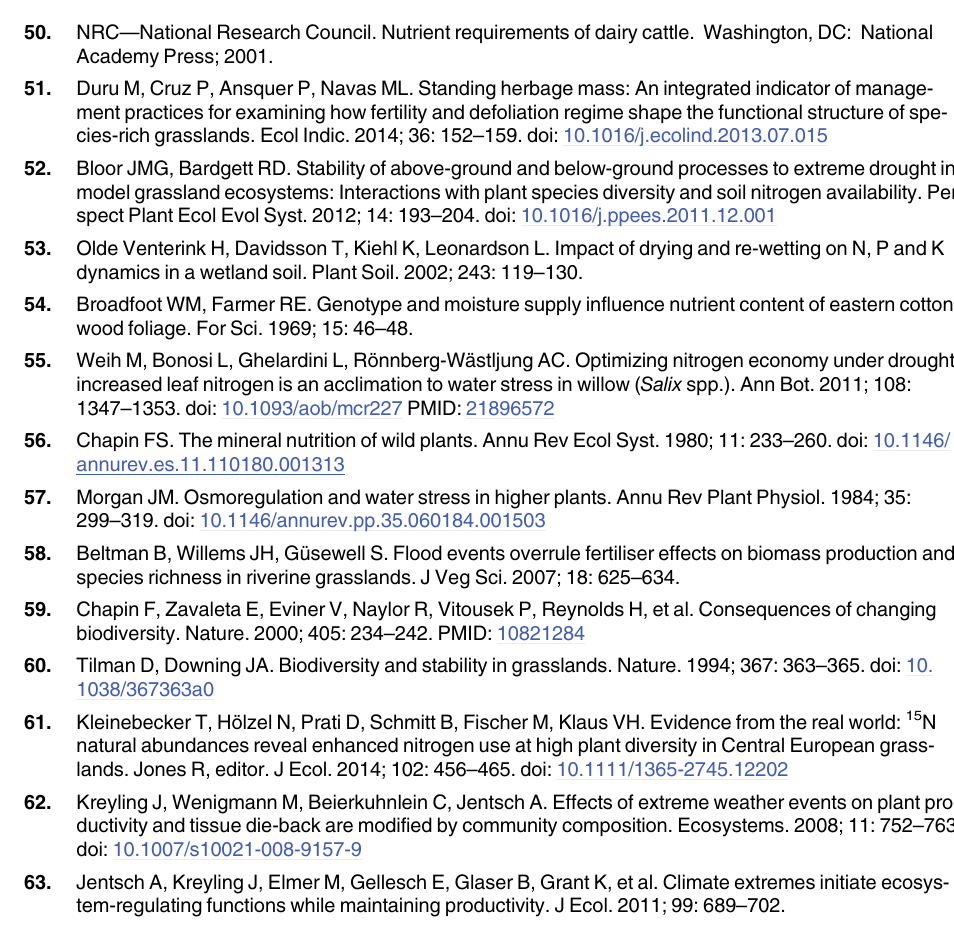
PLOS ONE | DOI:10.1371/journal.pone.0124140 May 7,